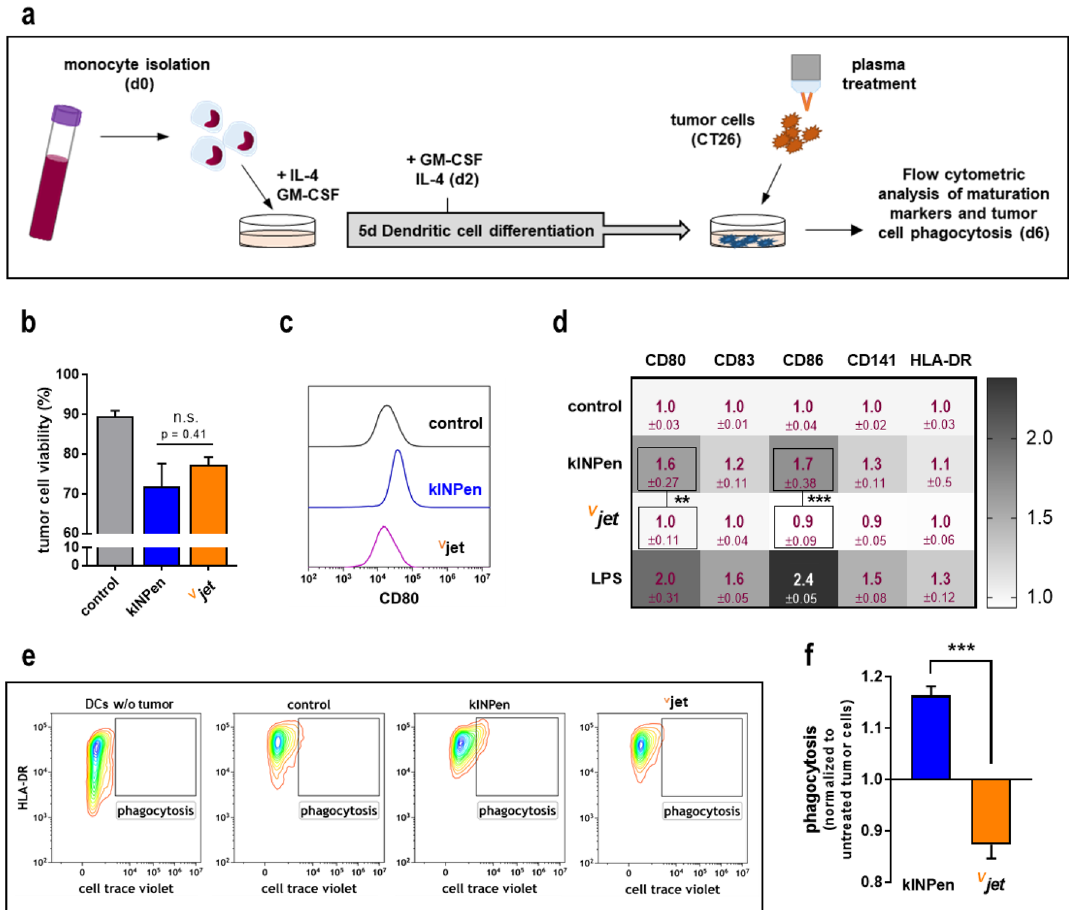
Figure 5. Tumor cell co-culture with and uptake by dendritic cells following plasma treatment. ( a ) Schematic overview of experimental procedure of co-culture experiments; ( b ) tumor cell viability 24 h after plasma treatment in co-culture with dendritic cells (DCs); ( c ) representative flow cytometry intensity histogram of CD80 expression on DCs after co-culture with plasma-treated tumor cells (CT26), and ( d ) quantification of maturation markers; Heatmap shows fold change of MFI normalized to control. ( e – f ) Representative flow cytometry contour plots of DC tumor uptake (e, and quantification ( f ). Data are representative of three independent experiments. Statistical analysis was performed using two-way anova or t-test (**p < 0.01; ***p < 0.001); n.s. = non-significant; LPS =